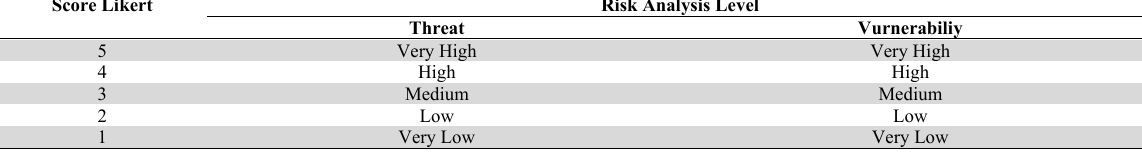
Terrorism Risk Analysis Level Value (Hosseinnia et al., 2018; Liua et al., 2012; Cioaca et al.,